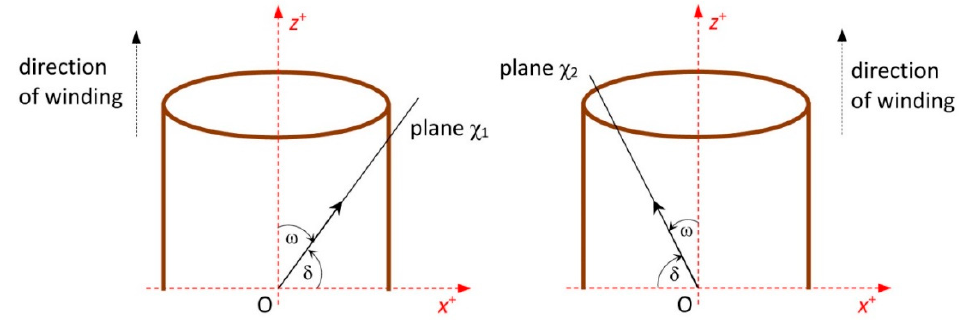
Figure 4. Scheme—front view of the non-bearing core frame with ( left ) positive and ( right ) negative angle of fiber winding on the frame. Winding angle ω is angle between central axis z of the frame and plane of fiber winding χ 1 (respectively χ 2 ).